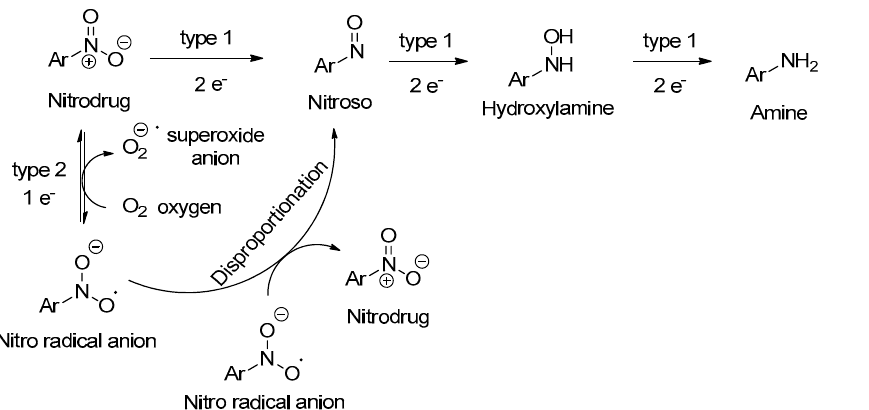
Scheme 5. Reduction mechanisms of nitroaromatic compound by type 1 and 2 nitroreductases.